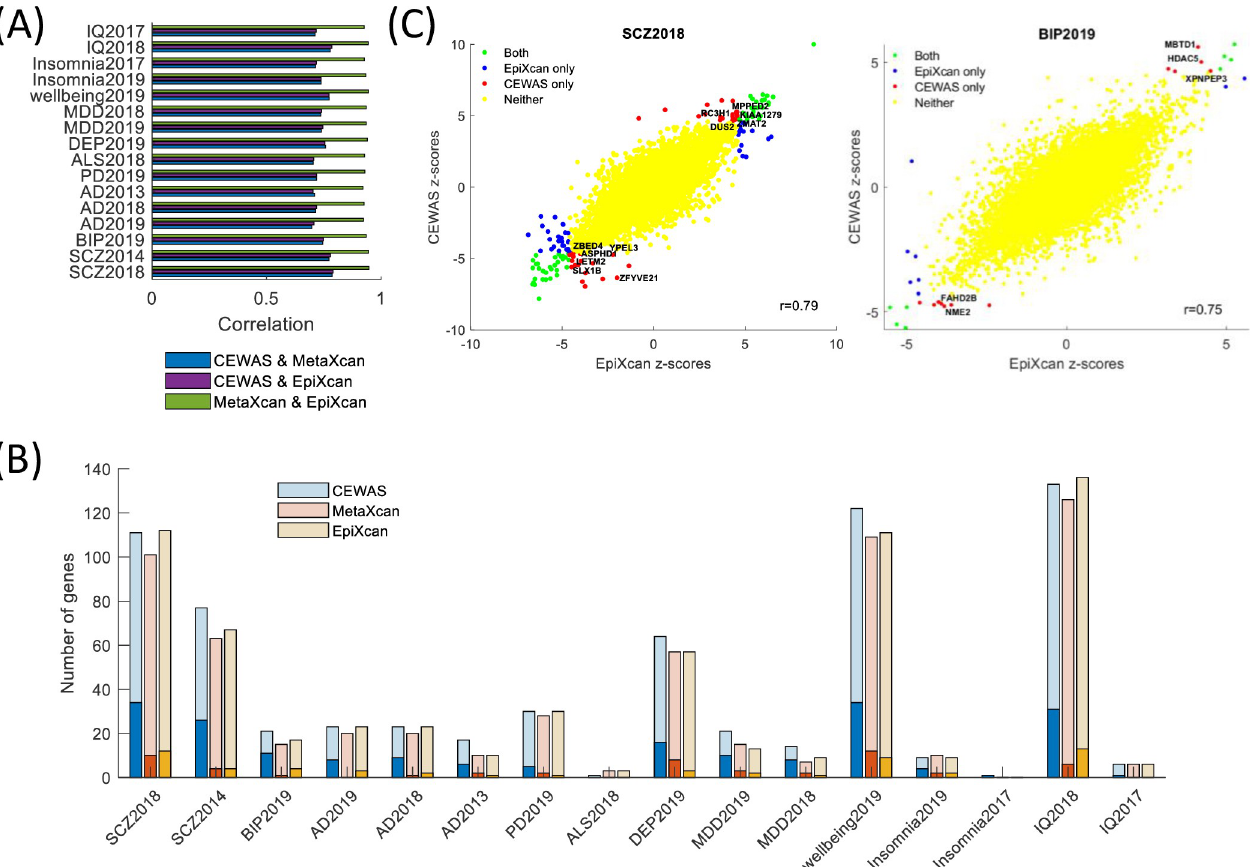
Fig 4. Method similarity and differential genes. (A) For each GWAS, correlation between z-scores estimated by the contrasted methods are shown. EpiXcan and MetaXcan tend to produce highly correlated z-scores. CEWAS z-scores are slightly more correlated with EpiXcan than with MetaXcan. (B) The darker shaded bars show the number of significant genes that were exclusively found by each method. The lighter shaded bars show the total number of significant genes found by each method. Only genes tested in all three methods were considered in computing the number of genes exclusively found by one method but not the other two. The number of genes exclusively found by CEWAS outnumbered MetaXcan and EpiXcan. (C) z-scores estimated by CEWAS vs. EpiXcan for SCZ2018 and BIP2019 displayed. Genes related to mitochondria dysfunction and oxidative stress exclusively detected by CEWAS but missed with MetaXcan and EpiXcan